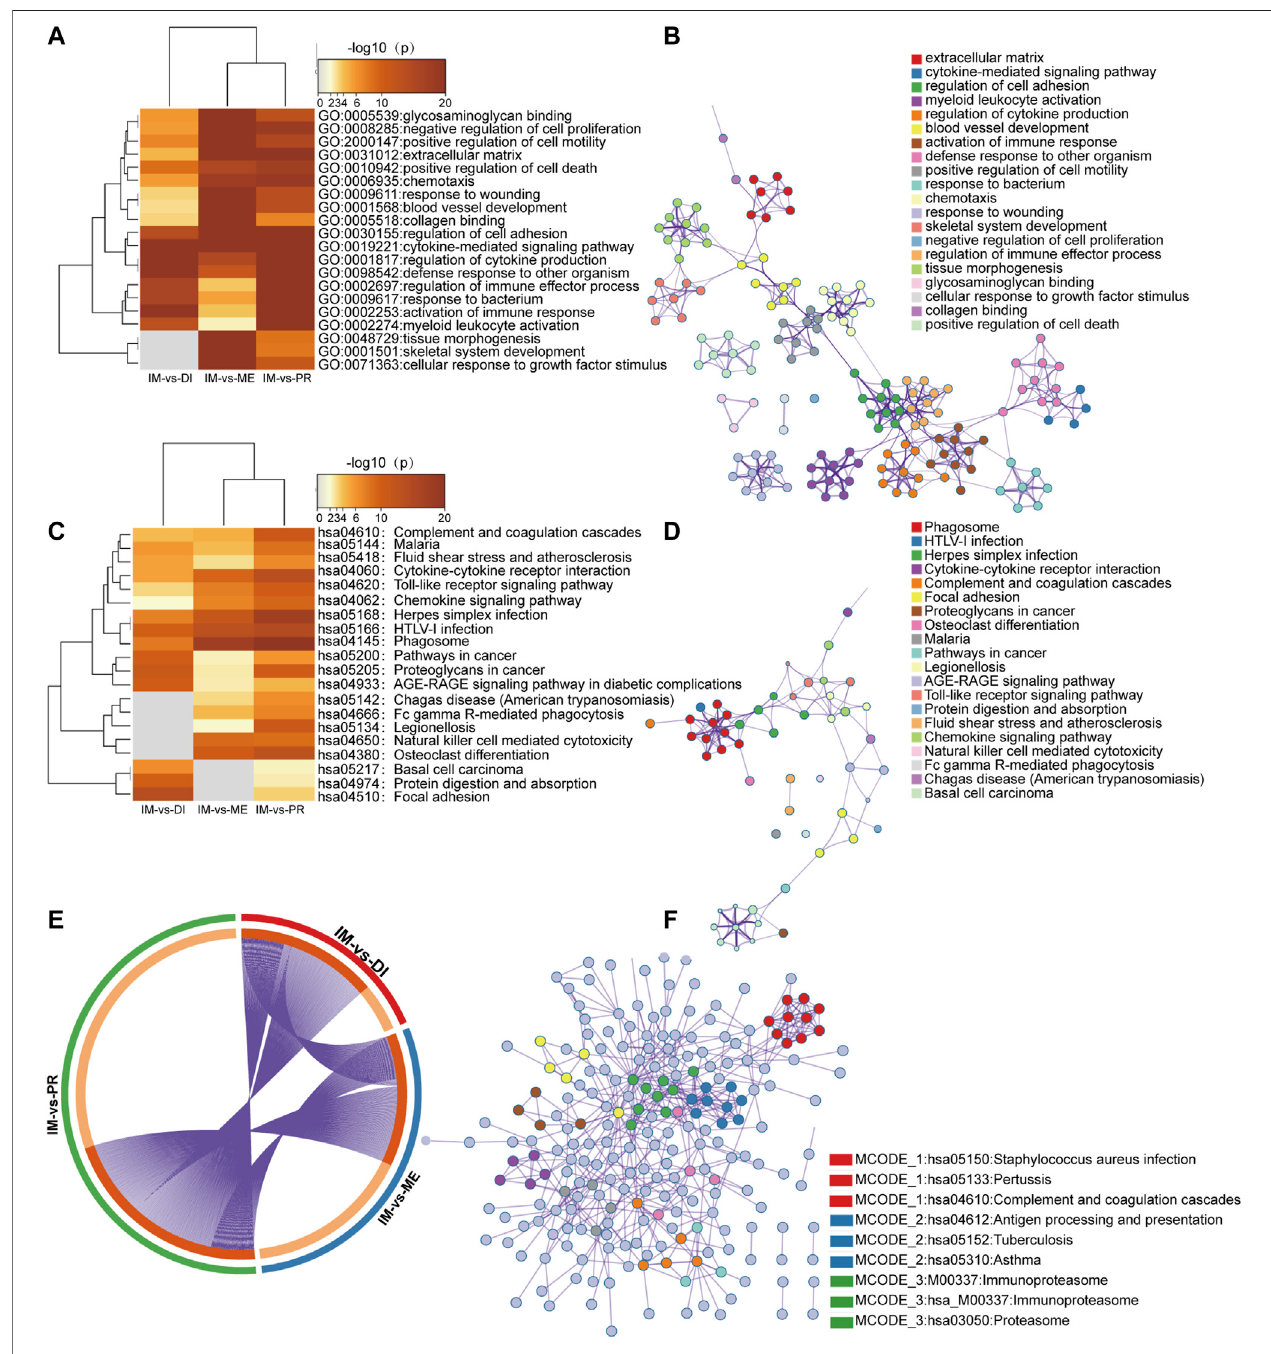
FIGURE 3 | Functional enrichment analysis and protein-protein interactions across three lists of DEGs between subtypes. Heatmap of GO terms (A) and KEGG pathway (C) enriched acrossthree DEGslists.A network ofenrichedterms was coloredbycluster-ID, where nodessharedthe samecluster-IDweretypically close toeach other, (B) GOenrichmentterms; (D) KEGGpathwayenrichmentterms. (E) Theoverlap betweenthreeDEGslists.Theoutercircleshowedeachcomparison group,andthe innercirclerepresentedthedistributionofDEGsineachgroup.Genesthathitthemultigrouplistwereshownindarkorangeandthosegenesthatdidnotwereshownin light orange. (F) Protein-protein interactions network and MCODE components of the KEGG pathway. The top three elements of MCODE were expressed in detail.